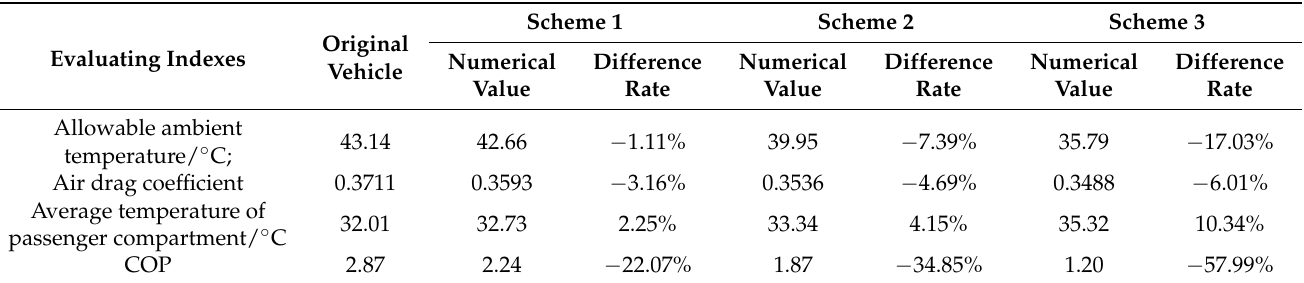
Table 10. Changes of evaluation indexes under different grille